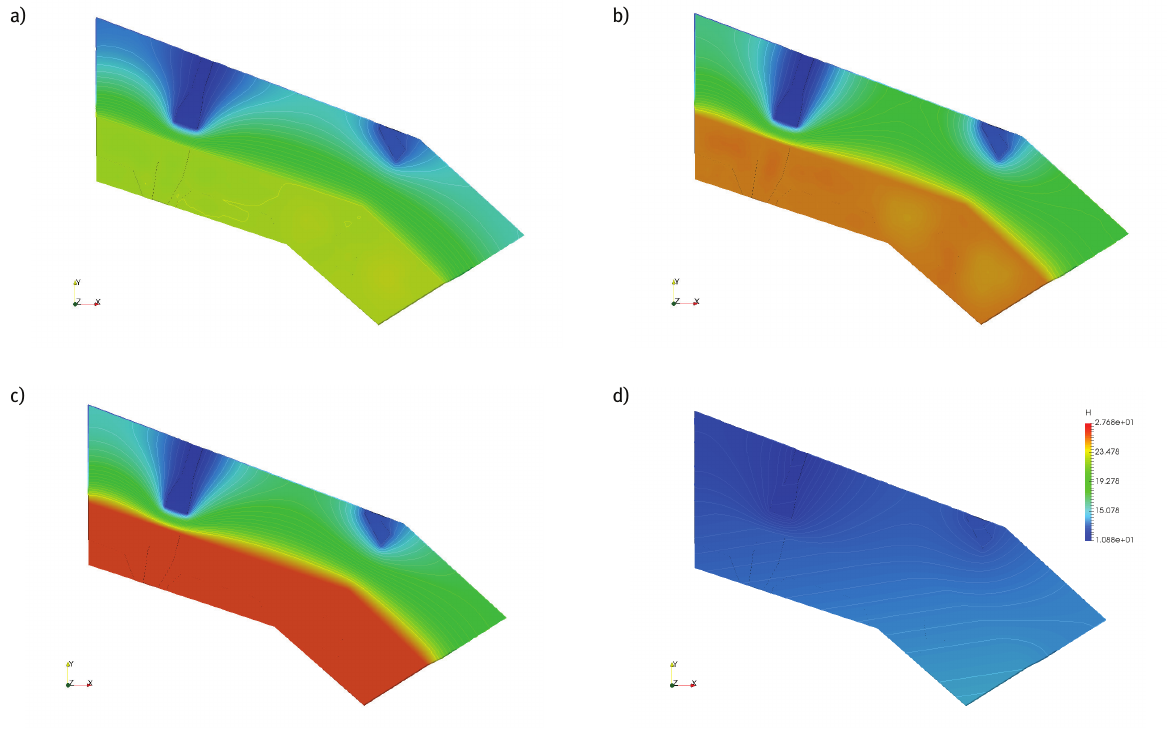
Figure 7: Isolines of hydraulic head relative to the roof of the gravel layer after: a) 1 day, b) 2.5 days, c) 15 days, d) 1 year.